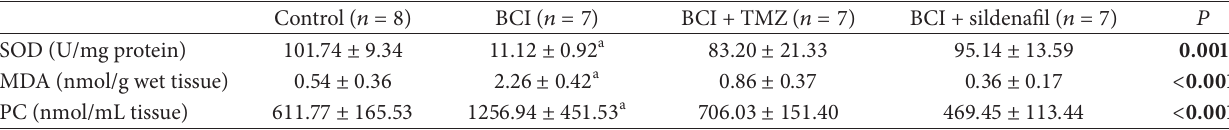
Table 1: Tissue SOD, MDA, and PC levels of the groups.